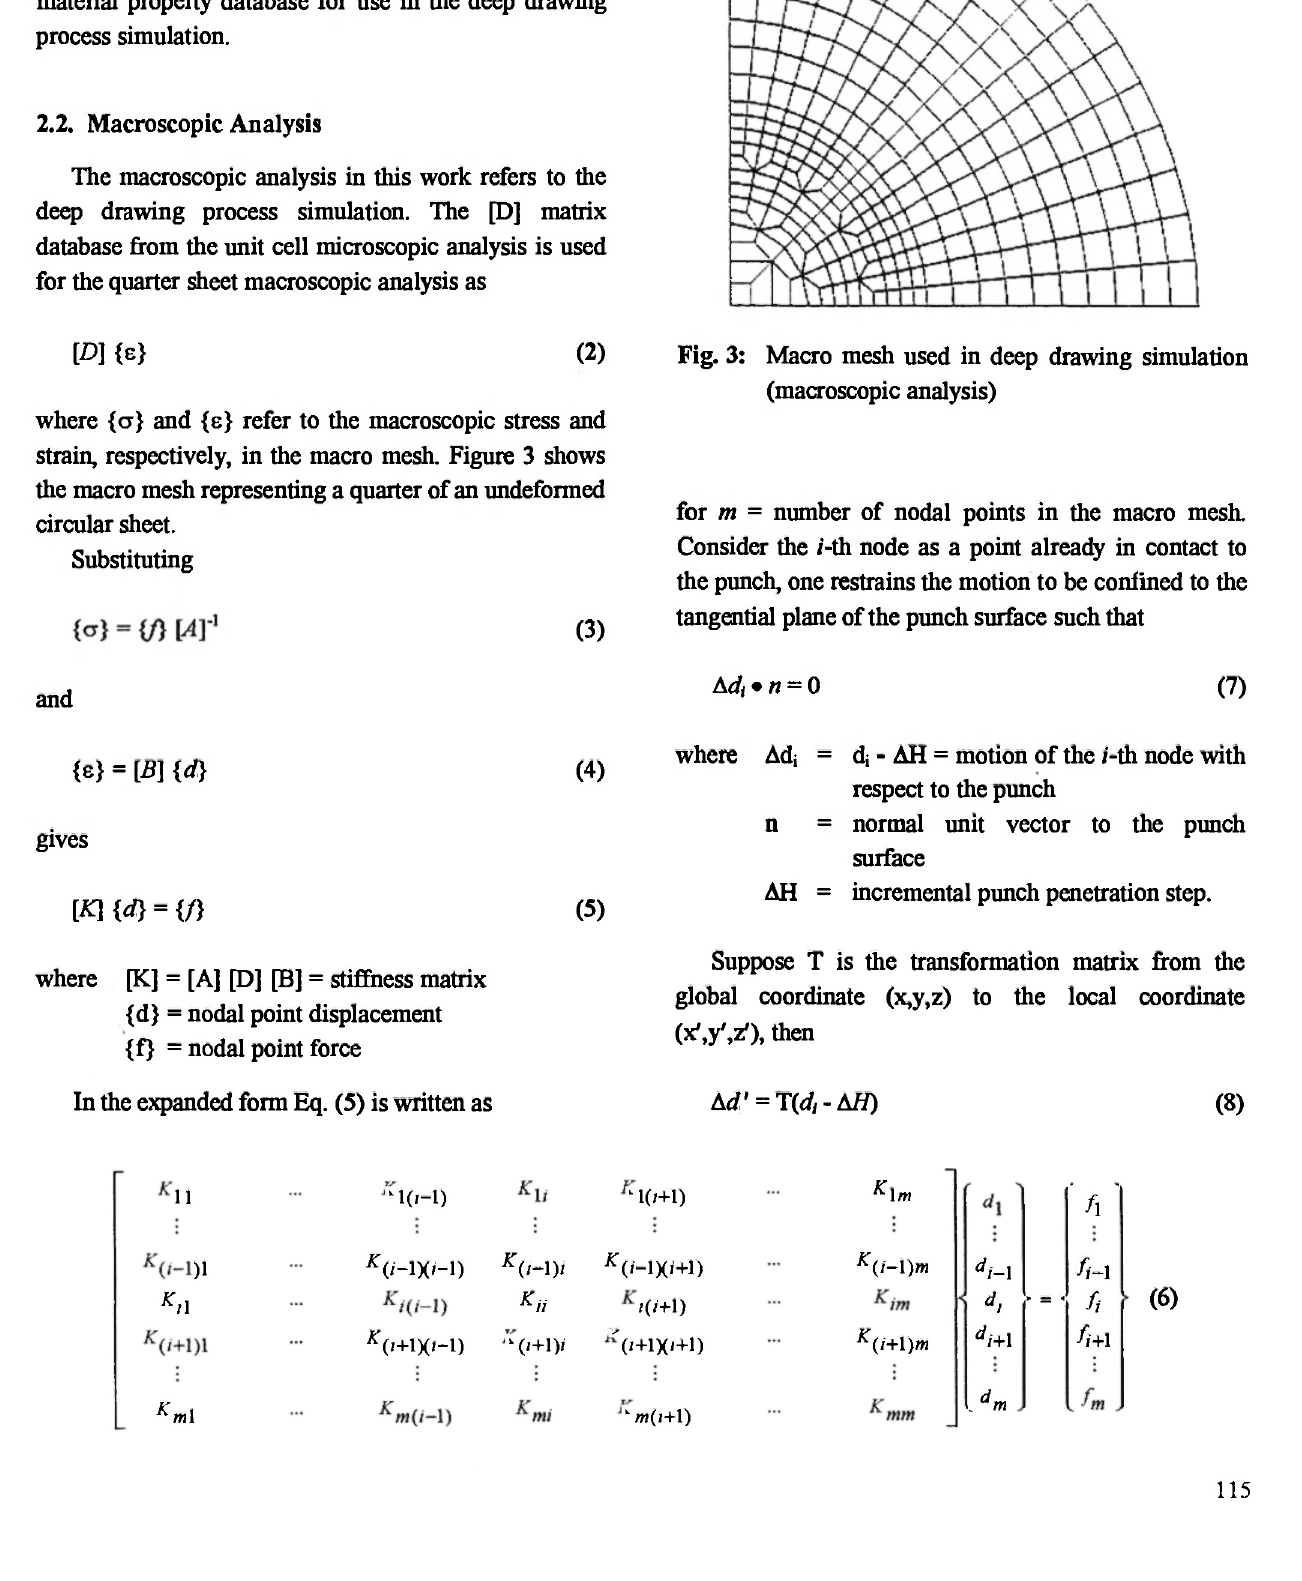
Fig. 3: Macro mesh used in deep drawing simulation (macroscopic